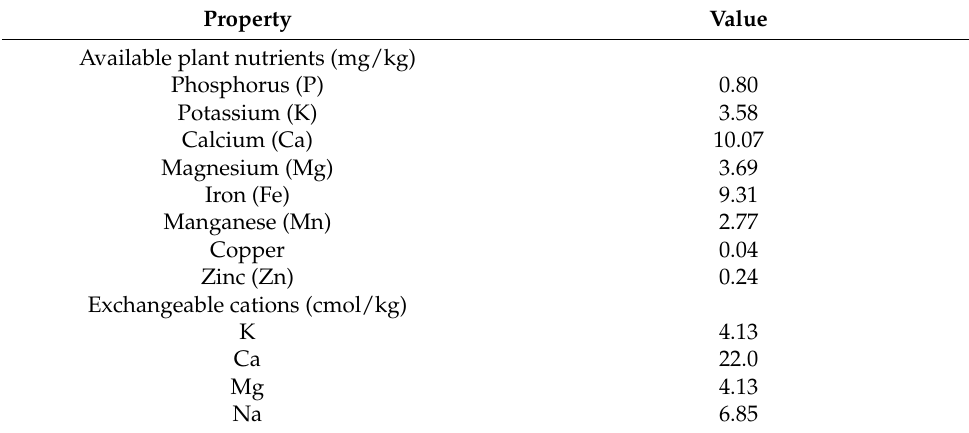
Table 1. Initial soil elements concentrations.